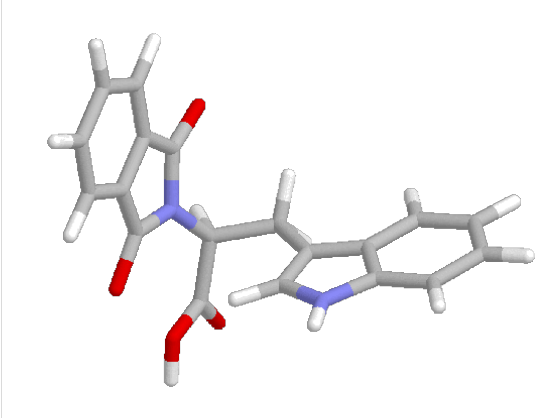
Figure 2: Structure of the tryptophan derivative 10 in the crystal.